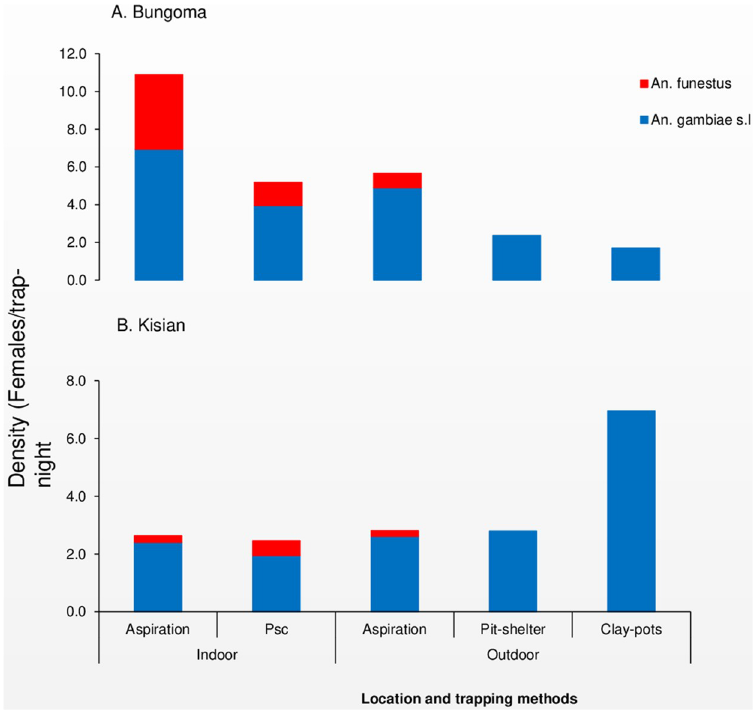
Fig 1. Indoor and outdoor resting density of female Anopheles mosquitoes collected per trapping method A: Highland site (Bungoma) and B: Lowland site (Kisian), western